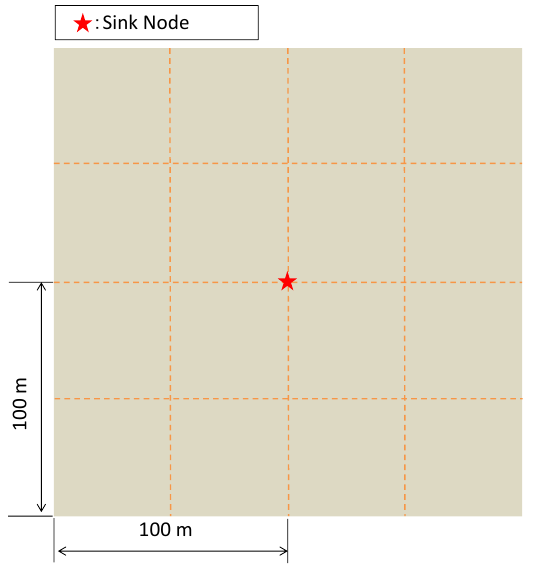
Figure 6. Square area for deploying sensor nodes. The sink is located at the center.